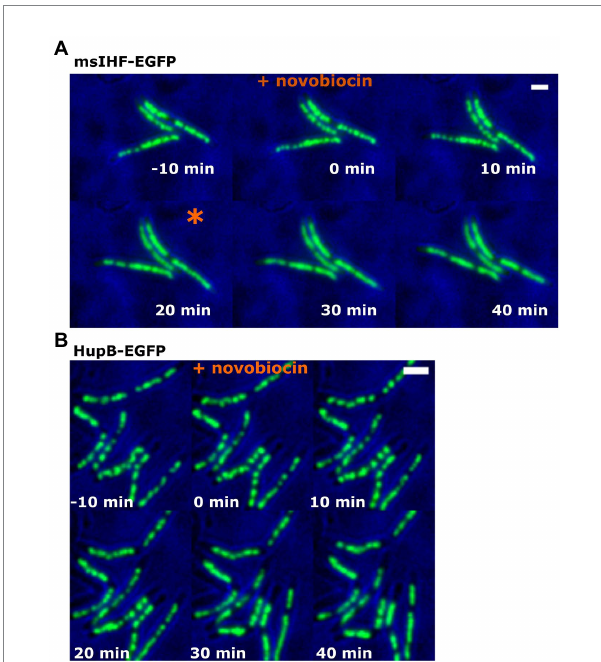
FIGURE 2 msIHF-EGFP and HupB-EGFP cells upon novobiocin treatment. M. smegmatis cells of msIHF-EGFP (A) and HupB-EGFP (B) strains were exposed to novobiocin (final concentration, 50 μ g/ml) for 6 h. The moment at which the bead-like pattern disappeared in msIHF-EGFP strain cells is marked with an orange star. Scale bar, 2 μ